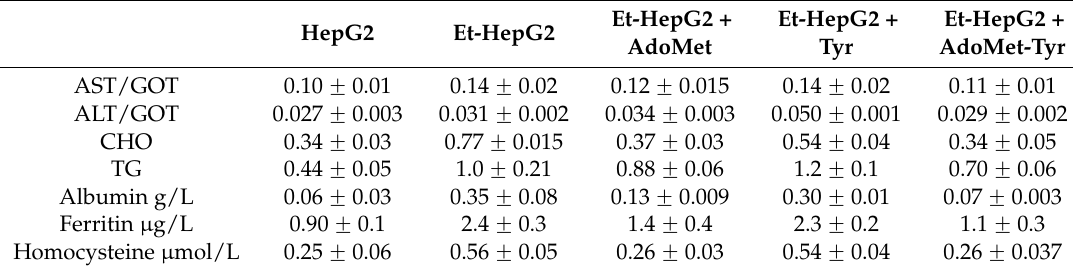
Table 1. Evaluation of liver enzyme, protein level and neutral lipid into the culture medium of EtOH-HepG2 treated for 48 h with AdoMet, Tyrosol and AdoMet-Tyrosol combination. HepG2 Et-HepG2